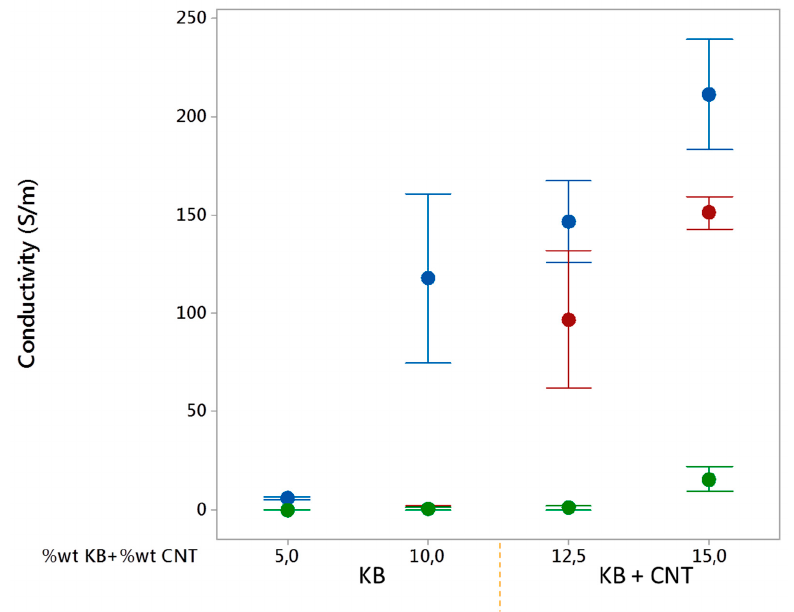
Figure 13. Electrical conductivity (S/m) as a function of KB and CNT ratios in the KB and CNT-filled LDPE. The CPCs without PBE are presented in blue, the 60 wt%CPC/40 wt% PBE blends in red and the 40 wt%CPCs/60 wt%PBE blends in green.